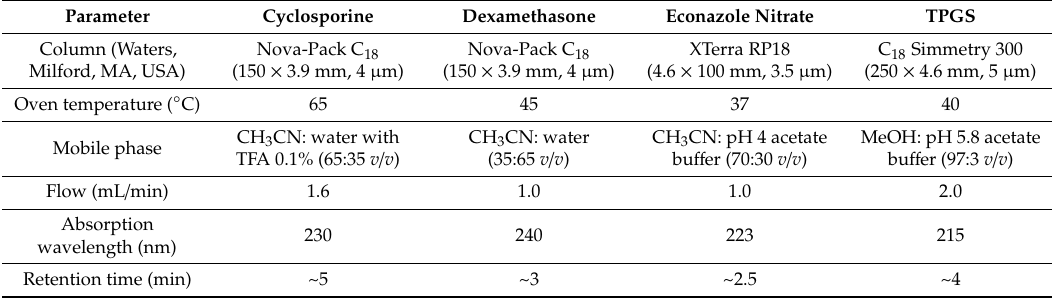
Table 3. HPLC-UV methods for the di ff erent